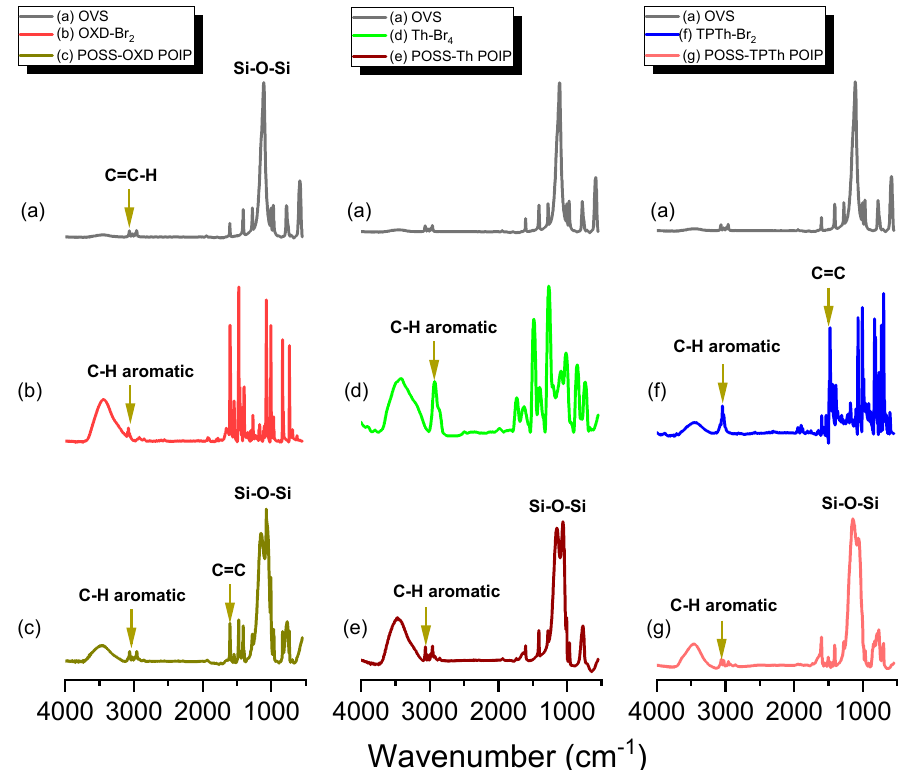
Figure 1. FTIR spectra of ( a ) OVS, ( b ) OXD-Br 2 , ( c ) POSS-OXD POIP, ( d ) Th-Br 4 , ( e ) POSS-Th POIP, ( f ) TPTh-Br 2 , and ( g ) POSS-TPTh POIP, recorded at 25 °C. The solid state 13 C NMR spectra of the POIPs (Figure 2a) featured signals for their carbon nuclei in the ranges 121.7–134.85 ppm for the POSS-OXD POIP, 130.64–133.62 ppm for the POSS-Th POIP, and 118.42–136.14 ppm for the POSS-TPTh POIP, corresponding to the aromatic and SiCH=CH carbon nuclei of their framework structures. Solid state 29 Si NMR spectroscopy confirmed the presence of POSS units in these POIPs frameworks (Fig- ure 2b), with signals at − 13.5 and − 80 ppm assigned to Si=CH 2 and T 3 moieties, respec- tively.